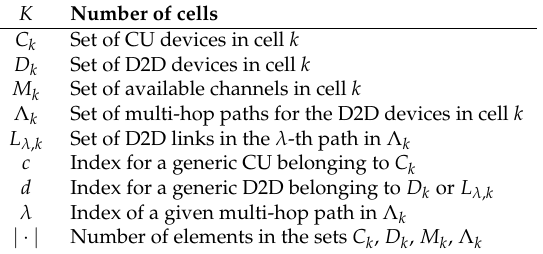
Table 1. Notations for the system